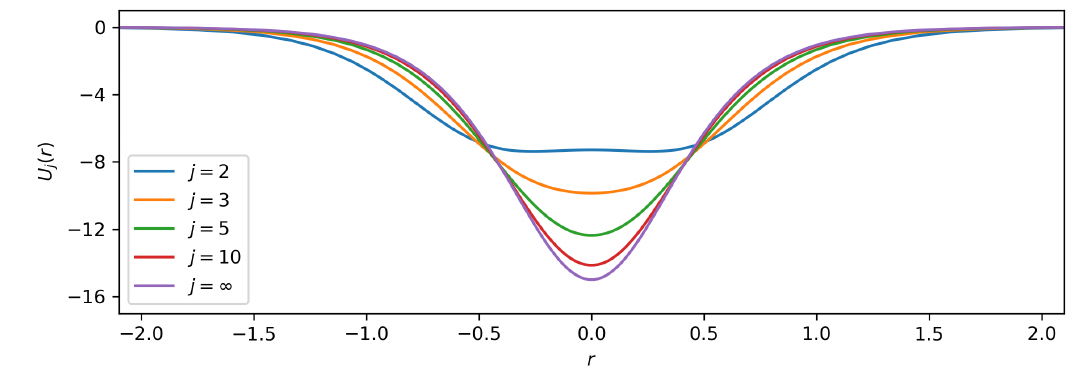
Figure 4. The potentials U j for the Schrödinger problem of eq.